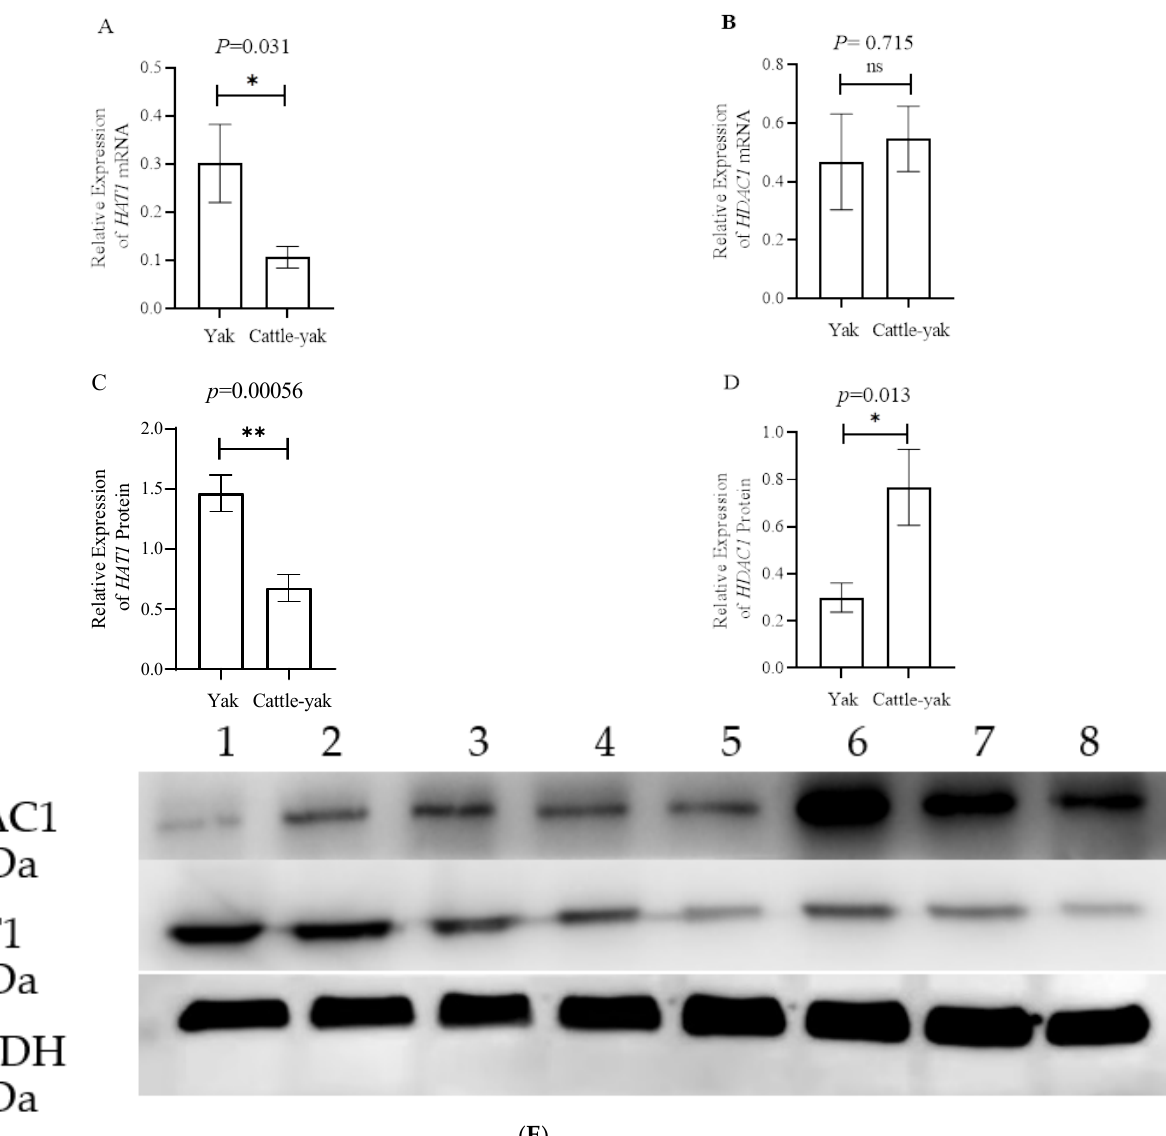
Figure 2. HAT1 and HDAC1 expression in the testes of yaks and cattle-yaks. ( A ) The relative expression of the HAT1 mRNA detected by real-time PCR; 18s rRNA was used as reference genes. ( B ) The relative expression of the HDAC1 mRNA detected by real-time PCR; 18s rRNA was used as reference genes. ( C ) The relative expression of the HAT1 protein between yaks and cattle-yaks. ( D ) The relative expression of the HDAC1 protein between yaks and cattle-yaks. ( E ) The expression of HAT1 and HDAC1 proteins detected by Western blotting. GAPDH was used as reference gene. Lanes 1–4 were yaks and lanes 5–8 were cattle-yaks. * p < 0.05 and **: p < 0.01.